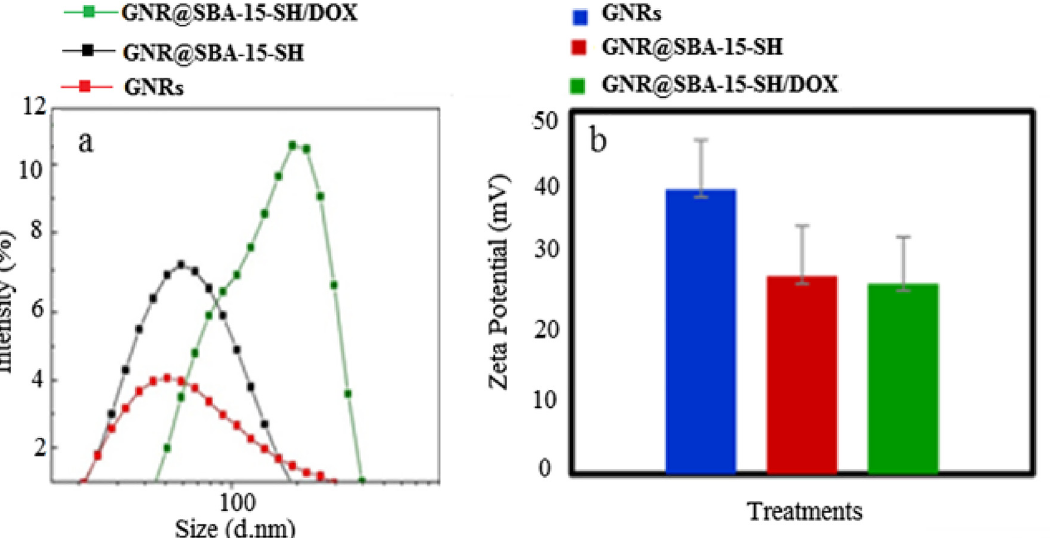
Figure8: (a)HydrodynamicsizeanalysisbyDLSand(b)SurfacezetapotentialofGNRs(CTABstabilized),GNRs@SBA-15-SH,andGNRs@SBA-